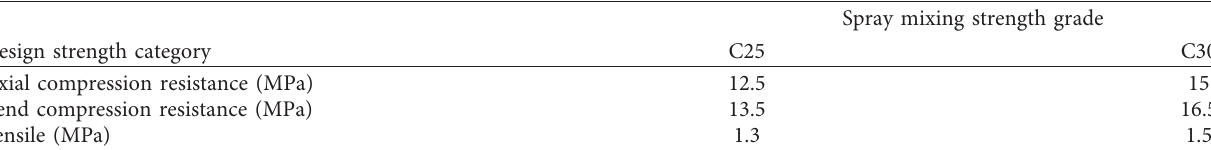
Figure 14: Convergence contrastive analysis of the left and right tunnel at RK0+280. Convergence deformation of (a) arch waist, (b) spandrel, and (c) arch foot. Table 2: Mechanical properties of shotcrete